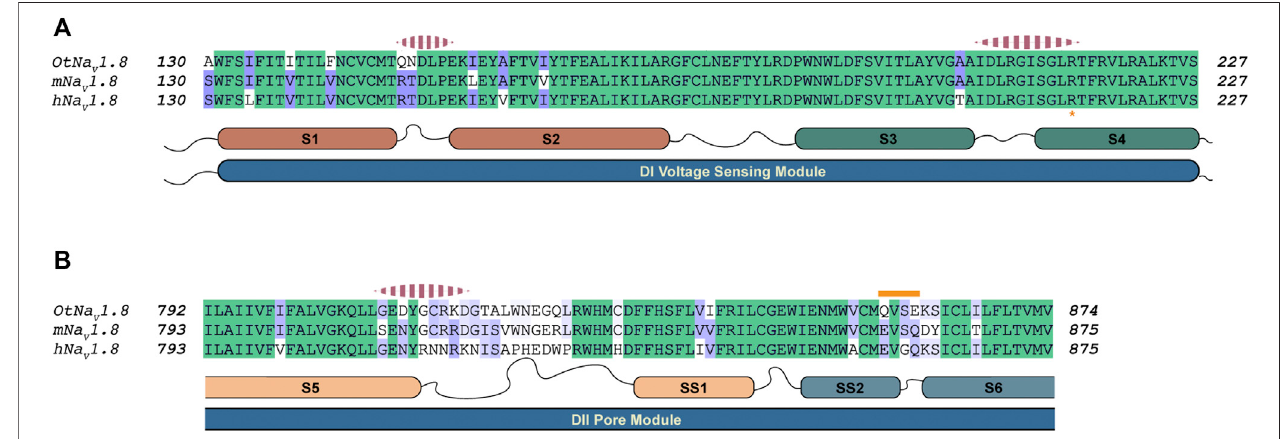
FIGURE 12 | Alignment of Na V 1.8 from grasshopper mice, house mice, and humans comparing predicted interaction regions between Na V 1.8 and NaTx36. Sequence from grasshopper mouse (OtNa V 1.8) DI voltage sensing module (S1 – S2 and S3 – S4) and DII pore module (S5 – SS1, SS2 – S6) was aligned with house mouse (mNav1.8) and human (hNav1.8) sequences to identify motifs uniquely present in OtNa V 1.8. The alignment color coding is based on sequence identity (high, green; medium, purple; low, white). Regions of the channel that were identi fi ed by docking simulations to interact with the toxin are highlighted with pink dashed segmentsabovethecorrespondingchannelsequence. (A) SequencealignmentDIvoltagesensingmodule;Orangeasteriskatthebottomofthealignmenthighlightsthe fi rst gating charge within theS4 segment. (B) Sequence alignmentcorrespondingtothe second Pore module. The orange bar above the sequence highlights theQVSE motif necessary for NaTx36 inhibitory effect on OtNa V